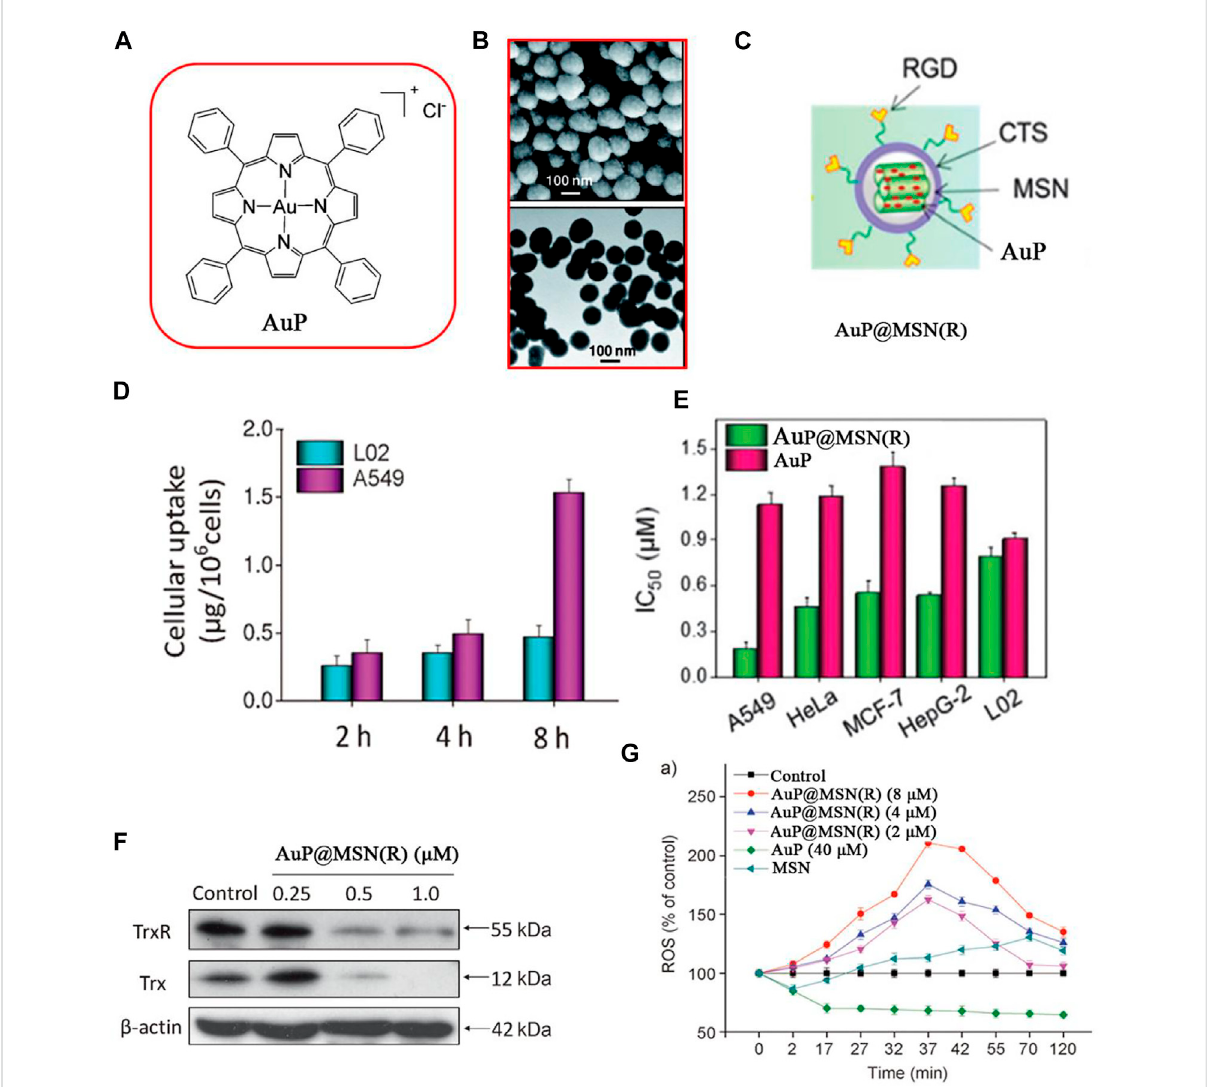
(Figure 13G) and activate ROS-mediated apoptosis signaling